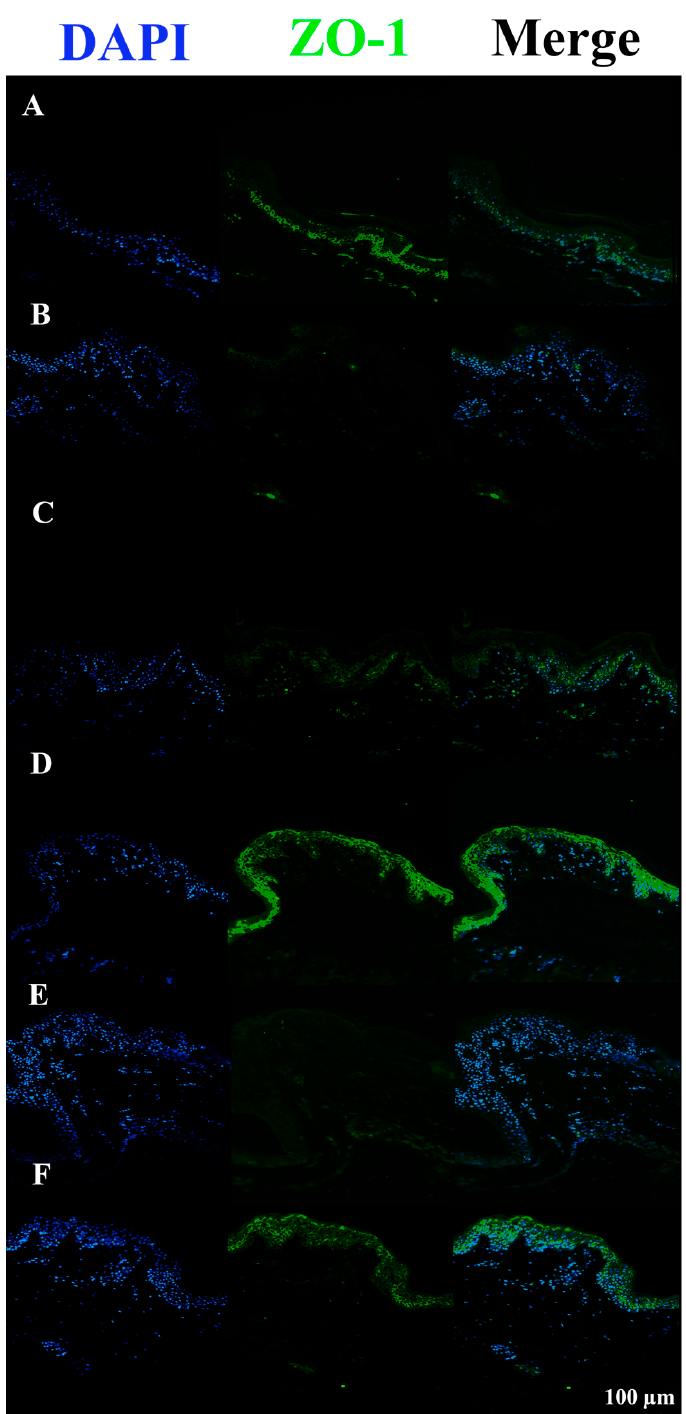
Figure 7. ZO-1 immunofluorescence on animal explant sections infected with S. aureus DSM20491 live bacteria (20 × magnification). DAPI (461 nm, blue) is shown on the left side; Anti-ZO-1 antibody Alexa488 nm-conjugated is shown in the middle; merge images are shown on the right. Lane description. ( A ) Not infected tissues; ( B ) not treated infected tissues; ( C ) c40 pre-incubated infected tissues; ( D ) HAc40 pre-incubated infected tissues; ( E ) c40 co-incubated infected tissues; ( F ) HAc40 co-incubated infected tissues. c40 and HAc40 pre-incubated and HAc40 co-incubated tissues revealed a ZO-1 signal (green) almost comparable to untreated control. Scale bar 100 µm.